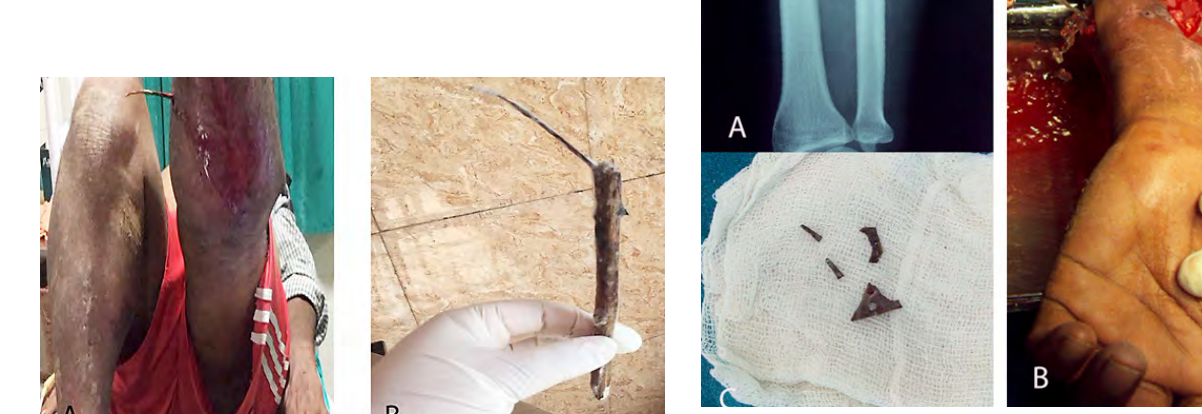
Fig 4 : A. Plain radiographs forearm showing radio opaque metallic foreign bodies; B. Per-operative pictures showing incisions to retrieve the foreign bodies; C. Extracted metallic foreign